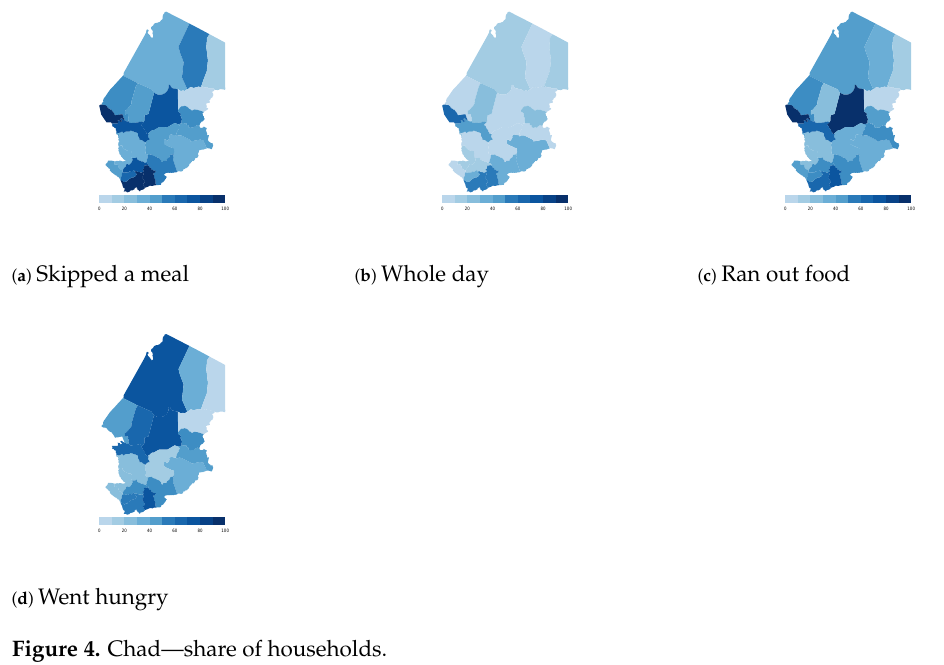
Figure 4. Chad—share of